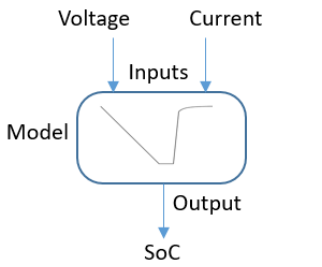
Figure 1. Battery SoC Model, based on the voltage and current